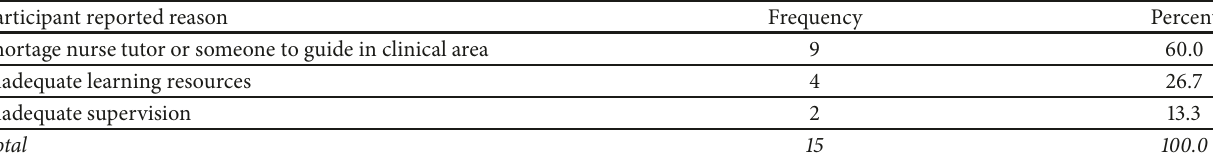
Table 4: Reasons why clinical placement does not give opportunity for learning